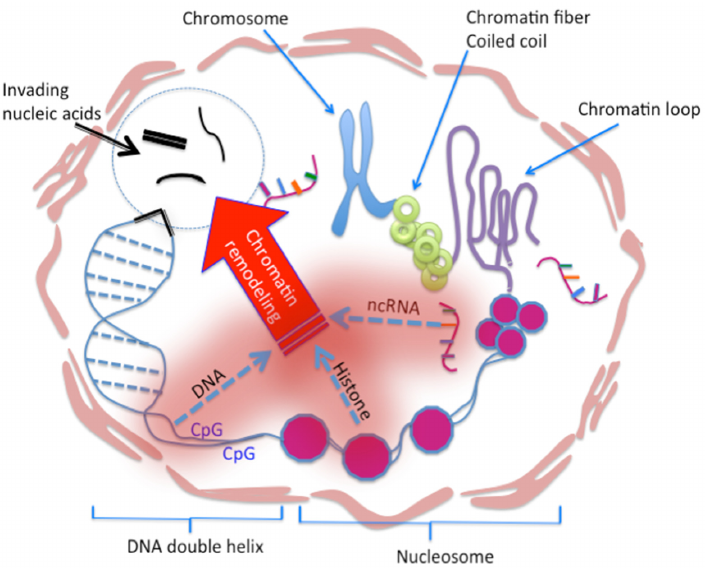
Figure 2. Epigenetic Immunity—a genetic immunity. A cell defends its genome against a foreign agent invasion by epigenetic immune regulations [9,10,127]. In HIV infection, the host cell protects its DNA from the viral nucleic acid attack by the epigenetic immunity, consisting of DNA methyla- tion, histone acetylation/methylation, and non-coding RNA (ncRNA) activity. DNA methylation affects the function of double stranded DNA, histone modification affects the function of nucleo- some, and ncRNA affects the function of chromatin. Each works independently but synergistically with the other two, guarding the topological structure and function of the DNA, and acting as a writer, reader, eraser, adaptor, modifier, organizer, or programmer [10,118,127]. The epigenetic fac- tors reprogram genetic immune responses embodying gene activation, silencing, epigenetic memory, and chromatin remodeling in responding to environmental stimuli, specifically patho- genic foreign nucleic acids such as HIV. 4.2. Chromatin Vaccine (cVaccine) cVaccine is a functional gene transcription unit with enhancer, in nucleosome format that resists nuclease degradation while mediating epigenetic silencing of viral RNA by ncRNA function and the enhancer decommissioning process [128–131]. It is well recognized that HIV infects naïve CD4 T-cells. CD4 T-cells have the stem cell property of self-renewal and differentiating into effector cells. The naïve CD4 T-cells analogize embryonic stem cell asymmetric division upon an antigen stimulation, and dif- ferentiate into memory and immune effector cells. Most importantly, these cells are dis- tributed into all body tissues and embody antigen specific lineage of CD4 cytotoxic T-cells (CTL), CD4 regulatory T-cells (Treg), CD4 follicular helper T-cells (Tfh), etc., to directly attack pathogen, regulate CD8 T-cell, B cell, and other immune cell functions. The enhancer decommissioning occurs routinely in stem cells, specifically in lineage differentiation into tissue specific effector cells by regulating the exact same genomic DNA. cVaccine is an immunogen (antigen), and functions as a primer of naïve CD4 T-cell enhancer, by triggering the signaling pathways of previously identified Toll Like Receptor (TLR), interferon and NF k B, to load the TF (transcription factor)/RNAPII to the CD4 T-cell enhancer. Such a primed cell enhancer allows CD4 T-cells to rapidly differentiate into ef- fector cells upon encounter with the HIV. The antigen specific differentiation of immune